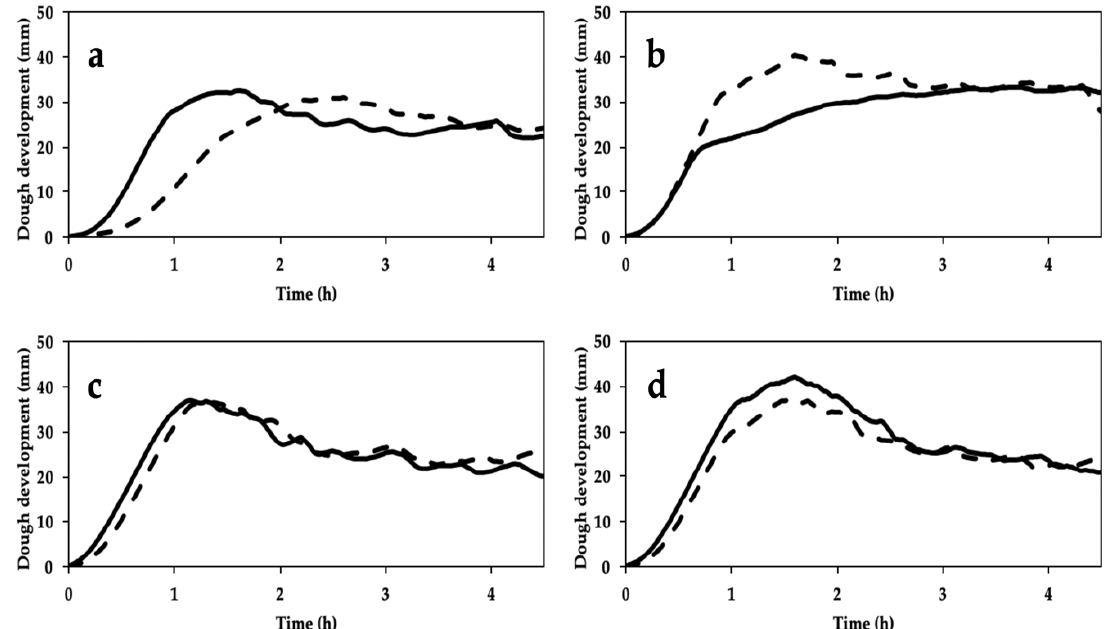
Figure 4. Effect of stone milling (solid line) and roller milling (dash line) on dough development, assessed by Rheofermentometer ® , during leavening of whole grain flours from Bolero cv ( a ), CWRS ( b ), Bona Vita cv ( c ) and Skorpion cv ( d ). CWRS: commercial Canada Western Red Spring Wheat.